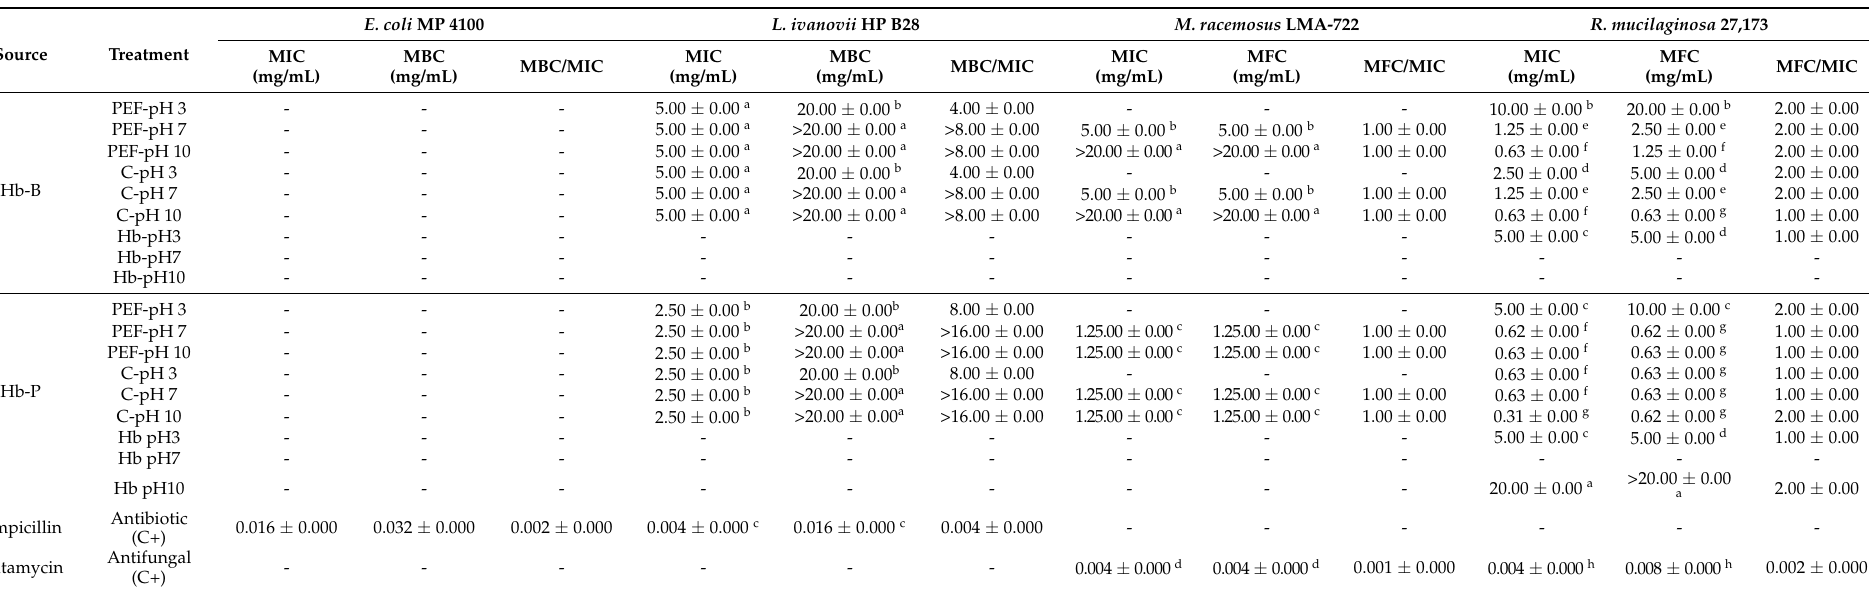
Table 2. Determination of MIC, MBC/MIC, and MFC/MIB of Hb-B hydrolysates or Hb-P hydrolysates at different pH values (3, 7, and 10) produced by pepsin after 3 h of